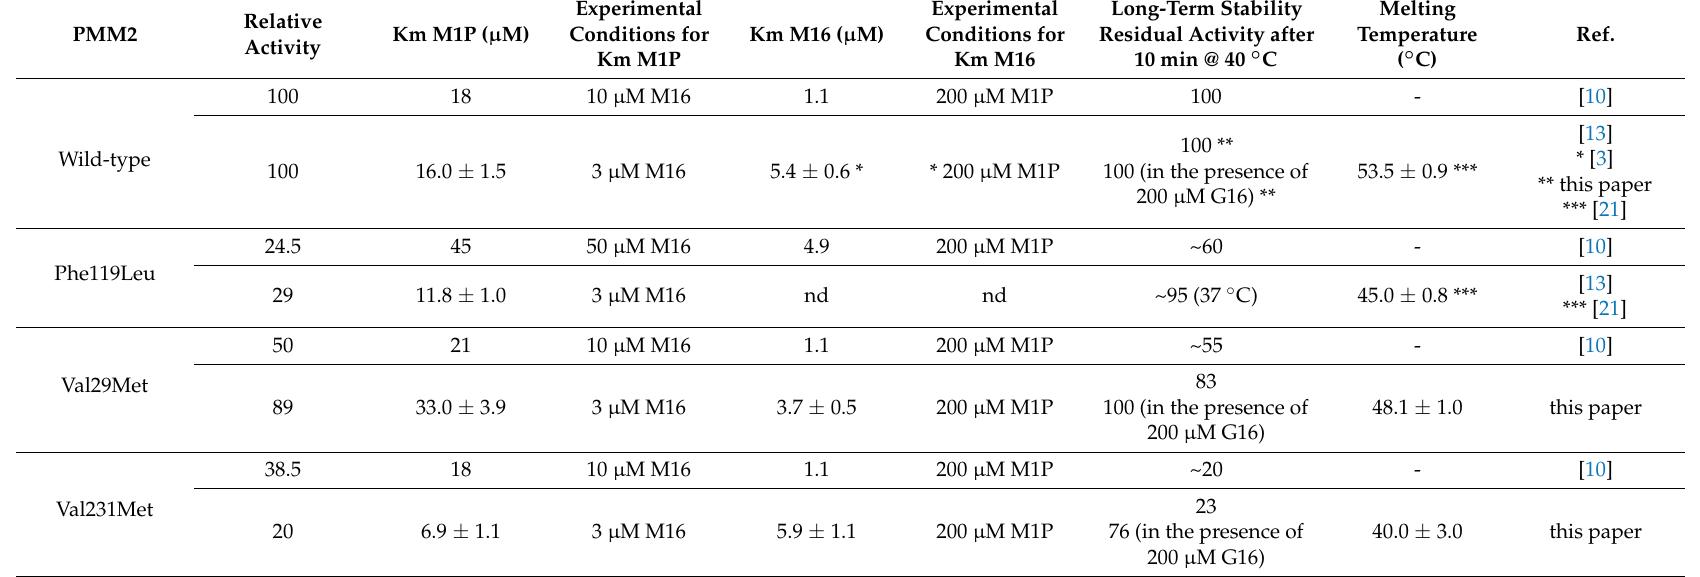
Table 1. Biochemical phenotype of some phosphomannomutase 2 (PMM2) variants. M1P: mannose